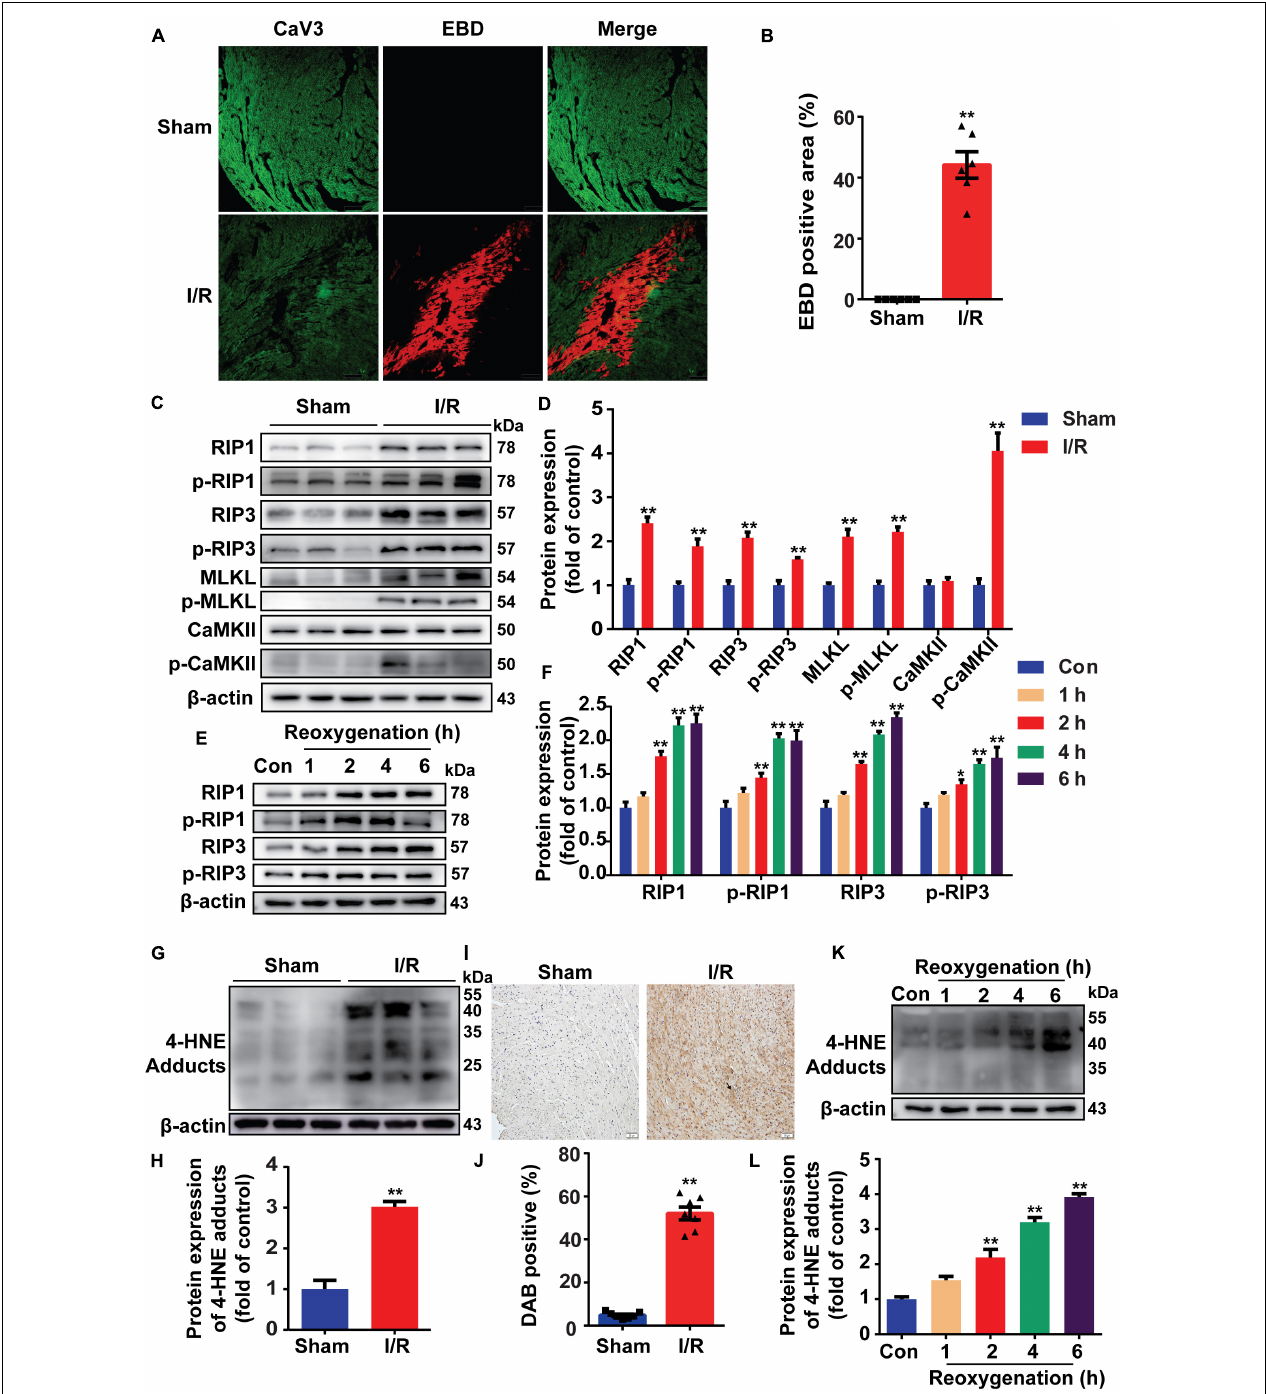
FIGURE 1 | Reperfusion injury induces cell necroptosis and increases 4-hydroxy-2-non-enal (4-HNE) production in mouse hearts and H9c2 cells. (A,B) Representative photomicrographs and analysis of necrotic area (red) and viable cardiomyocytes (green) in the sections of mouse hearts ( n = 6). Scale bar = 100 µ m. (C,D) Representative Western blots and relative expression of receptor-interacting serine/threonine-protein kinase 1 (RIP1), p-RIP1, RIP3, p-RIP3, mixed lineage kinase domain-like pseudokinase (MLKL), p-MLKL, Ca 2 + /calmodulin-dependent protein kinase II (CaMKII), and p-CaMKII in mouse hearts ( n = 6). (E,F) Representative immunoblots and relative expression of RIP1, p-RIP1, RIP3, and p-RIP3 in H9c2 cells under different reoxygenation times following hypoxia for 14 h ( n = 5). (G,H) Protein expression and relative expression of 4-HNE adducts in mouse hearts ( n = 6). (I,J) Representative immunohistochemical staining and analysis of mouse heart sections stained with anti-4-HNE antibodies ( n = 7). Scale bar = 50 µ m. (K,L) Protein expression of 4-HNE adducts in H9c2 cells under different reoxygenation times following hypoxia for 14 h ( n = 5). * p < 0.05 vs. sham (control) group; ** p < 0.01 vs. sham (control) group.